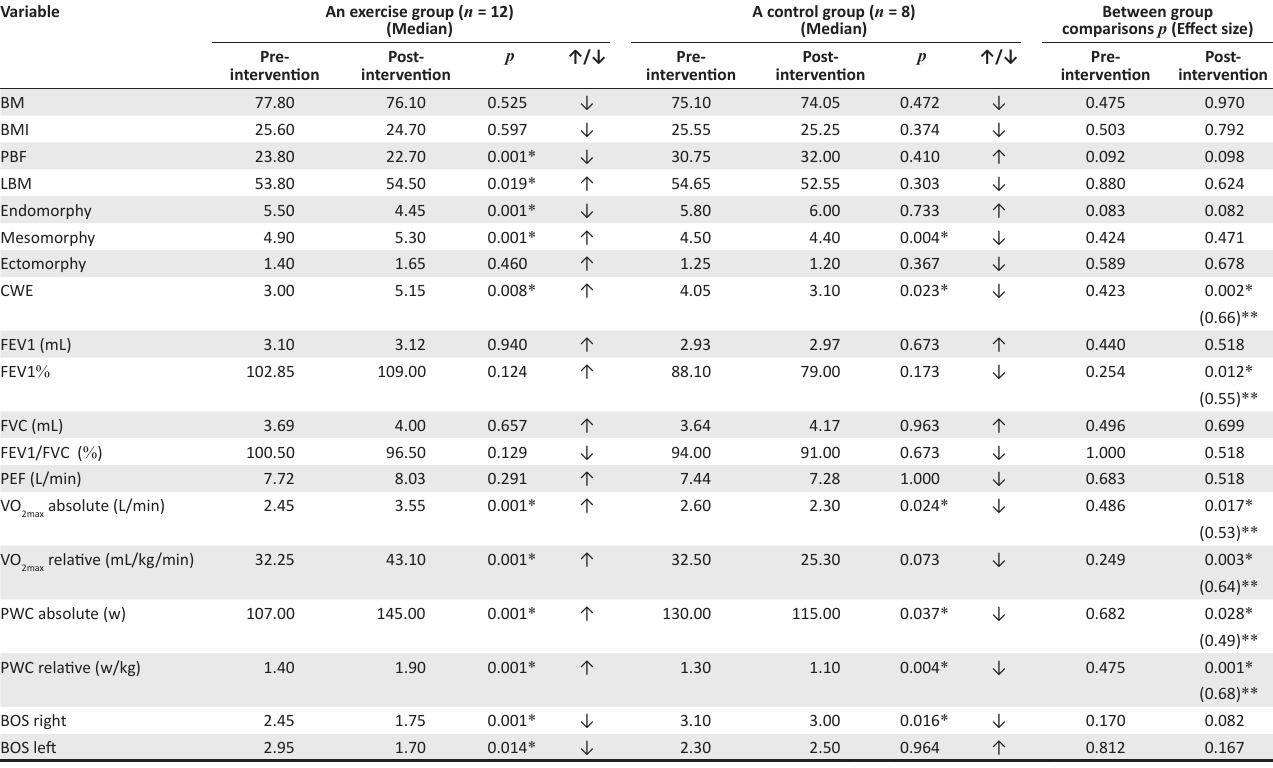
TABLE 4: Physical assessments pre-and post-intervention, within and between groups ( n = 20). Variable An exercise group ( n = 12) (Median)